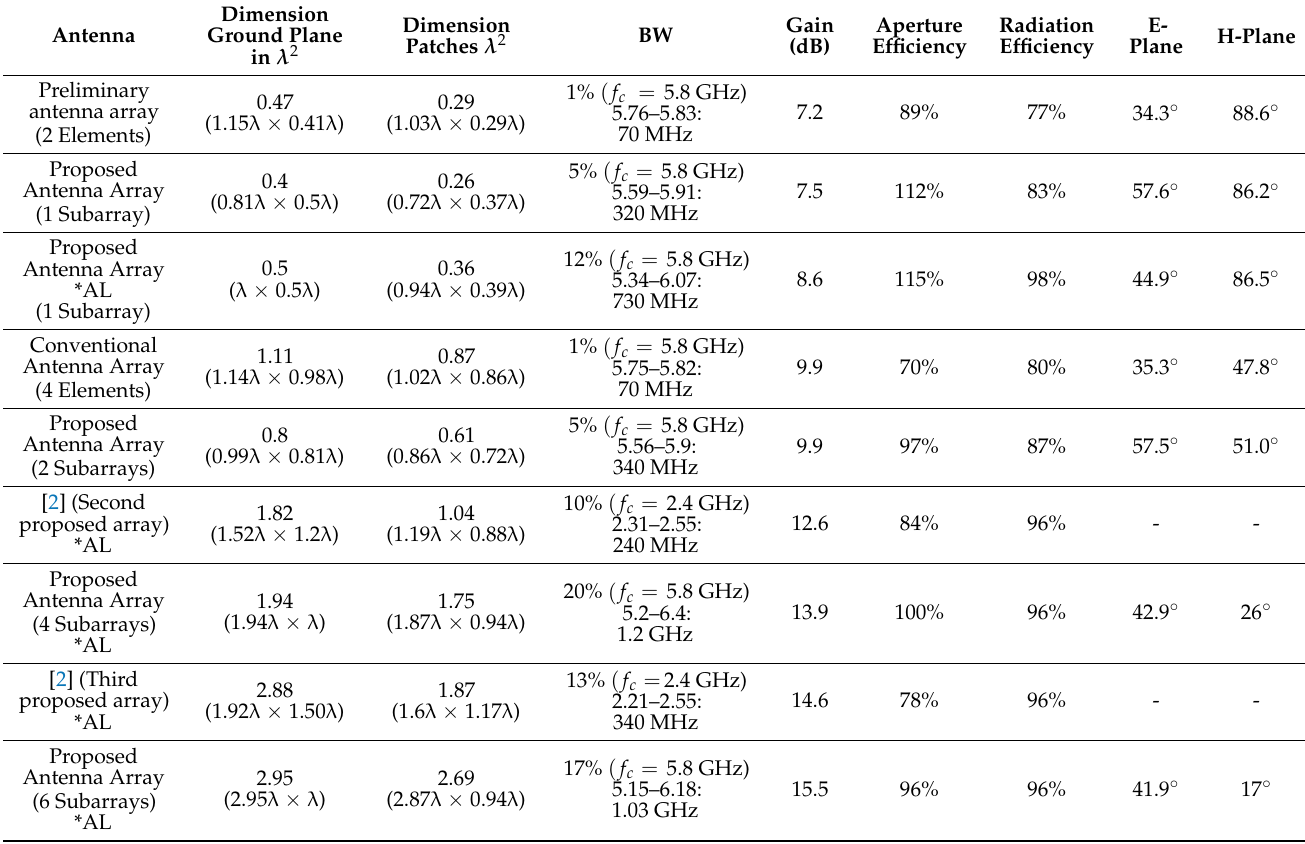
Table 2. Comparison of simulated results for conventional arrays, arrays in [2], and proposed antenna arrays.